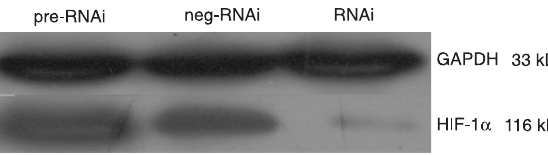
Figure 4 . The stromal cells in the RNAi group expressed a lower level of the hypoxia-inducible factor-1α (HIF-1α) protein (average gray value = 0.336 ± 0.053) than in the pre-RNAi group (average gray value = 0.845 ± 0.084; P < 0.05) and the neg-RNAi group (average gray value = 0.798 ± 0.079; P < 0.05) at 4 days after infection, indicating that the RNAi lentivirus vector targeting HIF- 1α could efficiently knock down the protein expression of HIF-1α. The t -test was used for statistical analyses.